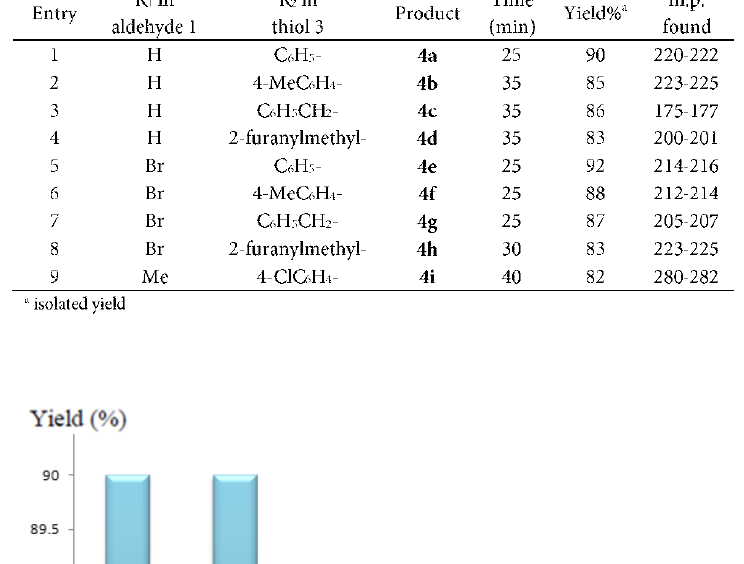
Fig. 9. Recycling of Co